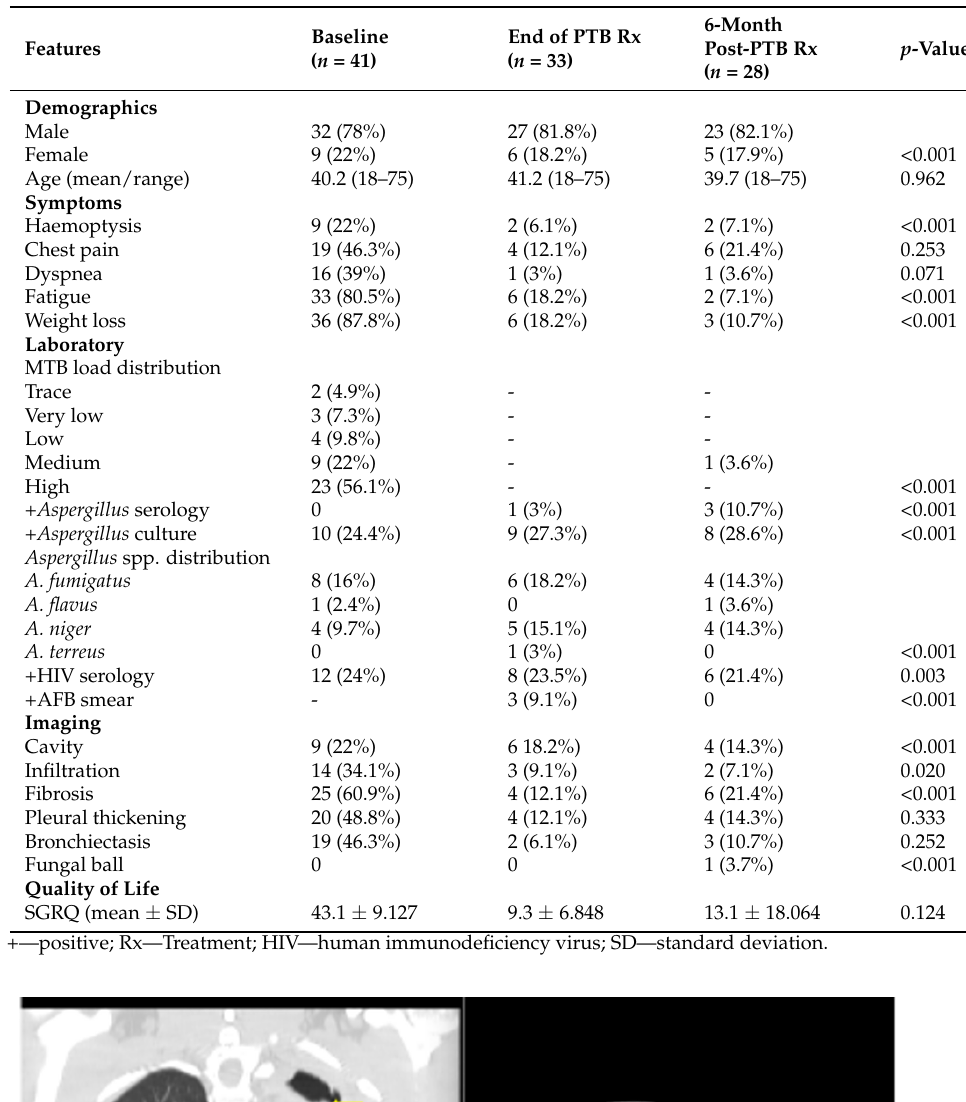
Figure 3. Axial contrast CT scans, axial lung window of chest of another CPA patient diagnosed at T 2 showing ( A ) a soft tissue mass within a left apical lung cavity (blue arrow) with a characteristic crescent of air around it, the ‘Monod sign’, indicative of an aspergilloma. ( B ). Nodular opacities (red arrow) and non pericavitary fibrotic changes in the left upper lobe. Figure 4. Axial non contrast CT scan, axial mediastinal and lung windows of the chest of the third CPA patient diagnosed at T 3 patient, demonstrating ( A ) right lung nodules (blue arrow); ( B ) small right lower lobe cavity with pericavitary infiltration (red arrow) as well as a small pleural effusion (yellow arrow).